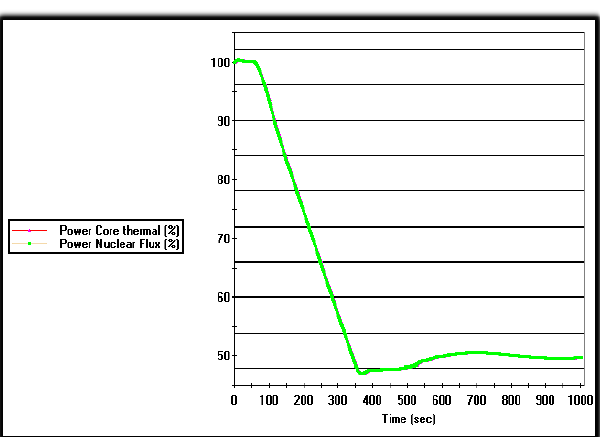
Fig. 11 . Dynamics of turbine power load